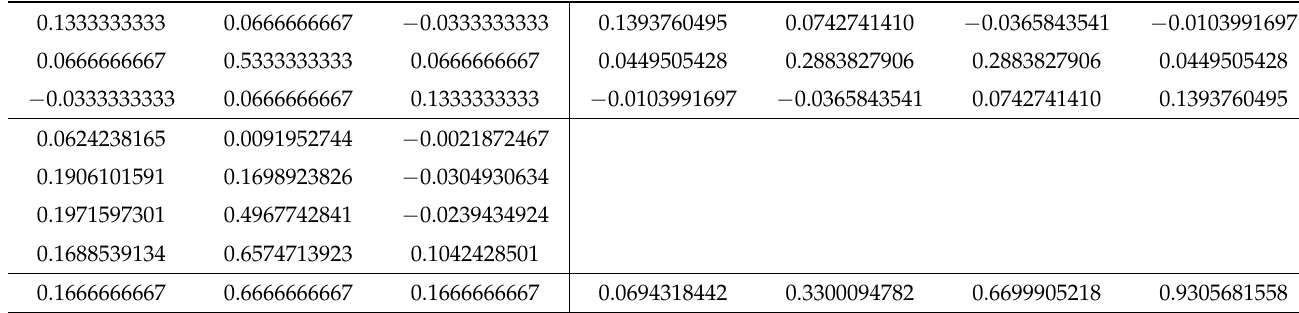
Table A23. L3|G4 method.